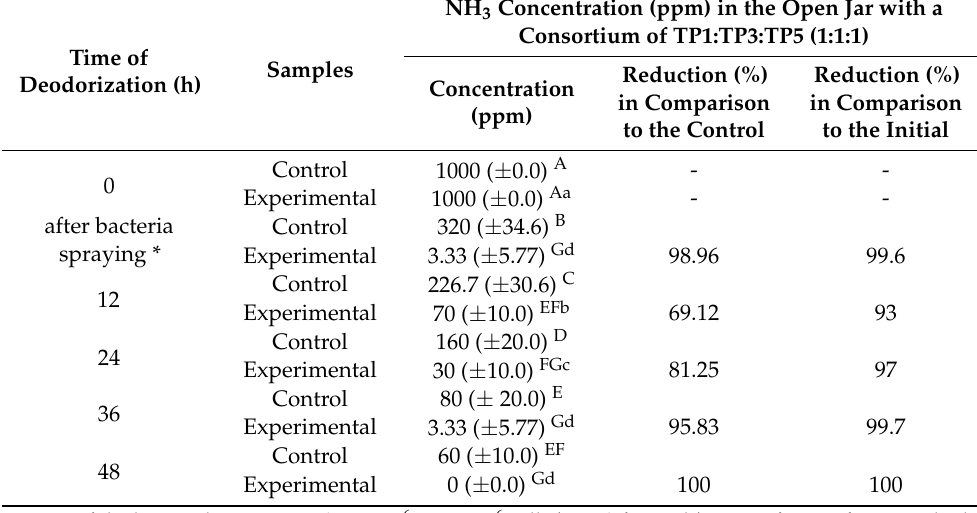
differences only among the evaluation periods in the experiment ( p < 0.05). Different superscript capital letters indicate statistically significant differences among the evaluation periods in the control and experiment ( p <